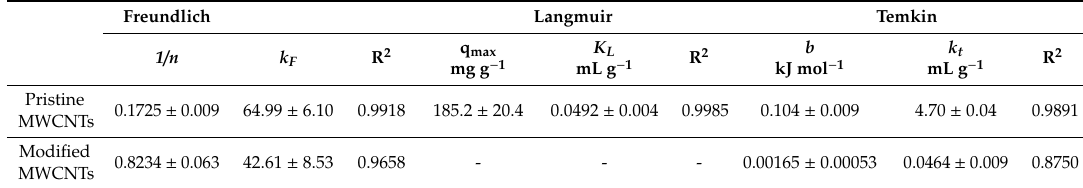
Table 2. List of calculated isotherm parameters ( ± SD) for di ff erent models of DOX adsorption on pristine and modified MWCNTs at 298.15 K. Freundlich